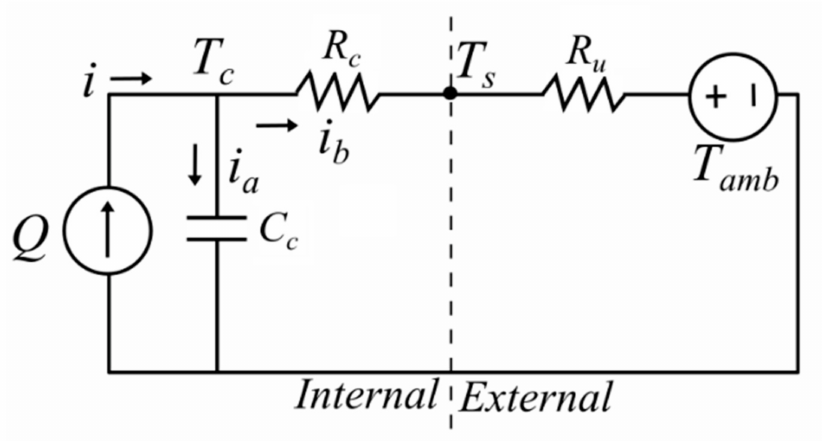
Figure 2. First-order heat resistor–capacitor-based thermal model of